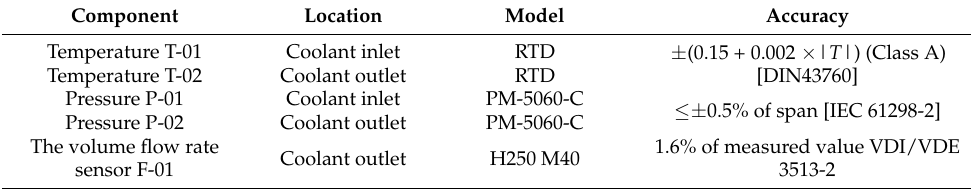
Table 5 . Parameters of HPEE experiment’s measuring instruments applied to heat sink. Table 5. Parameters of HPEE experiment’s measuring instruments applied to heat sink.